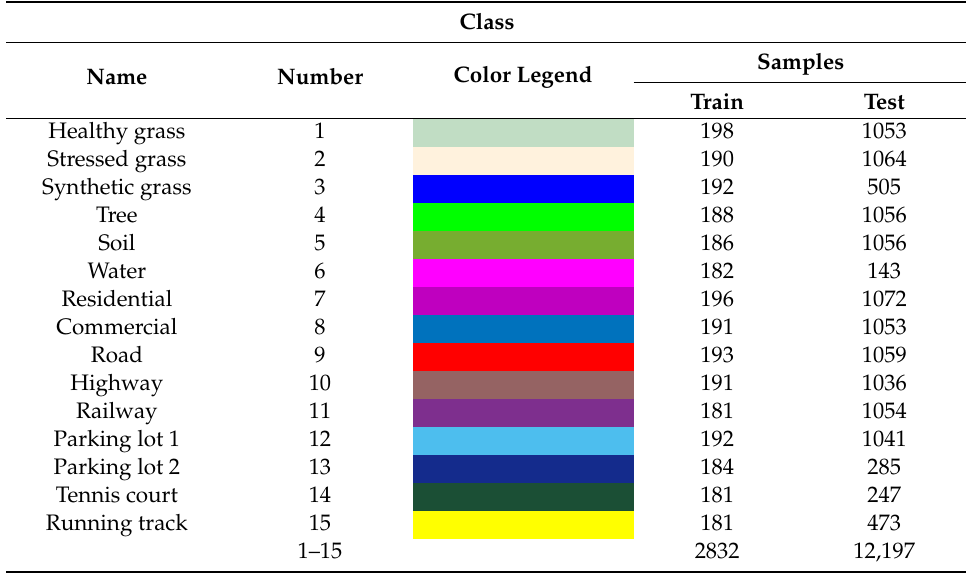
Table 1. Number of pixels per class in the IEEE GRSS data. Total number of unlabeled pixels is 649,816, and total number of pixels is